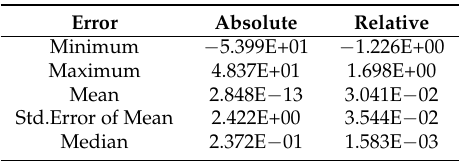
Table 3. V2I density estimation